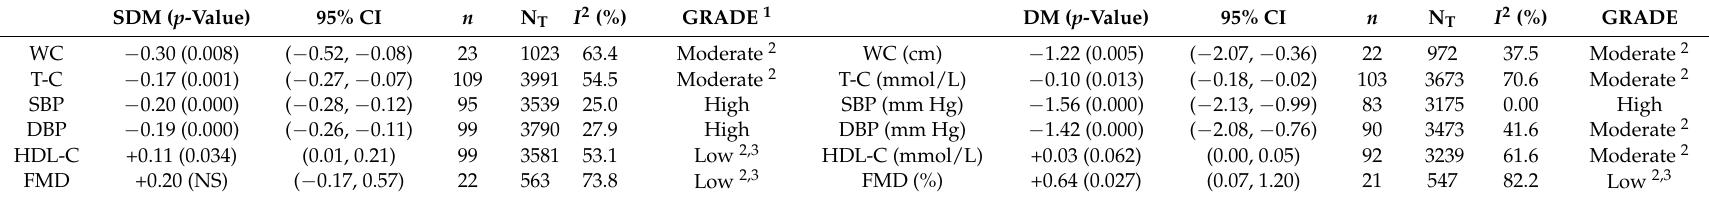
Table 1. Summary of the most significant global effects of foods and food products containing ETs and ANCs on biomarkers of cardiometabolic risk.